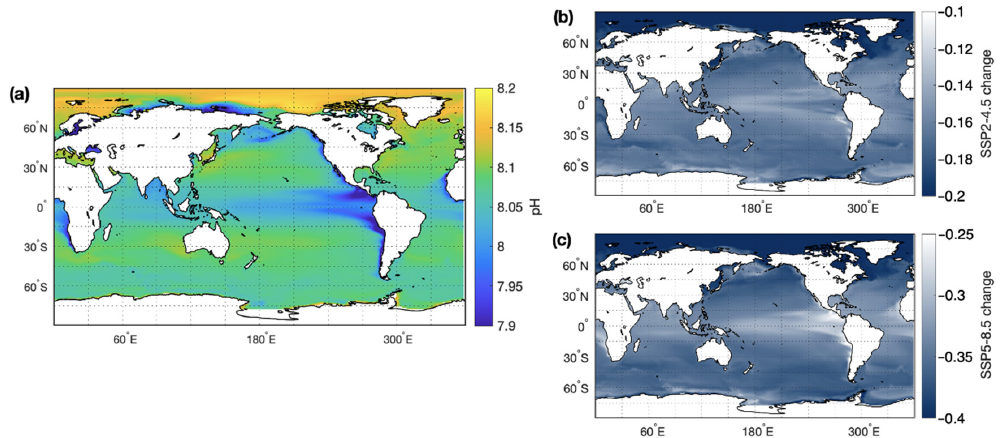
Figure 4. ( a ) Annual mean pH and the change in pH by the end of this century, as simulated for climate under two emission scenarios: ( b ) SSP2 ‐ 4.5 and ( c ) SSP5 ‐ 8.5.